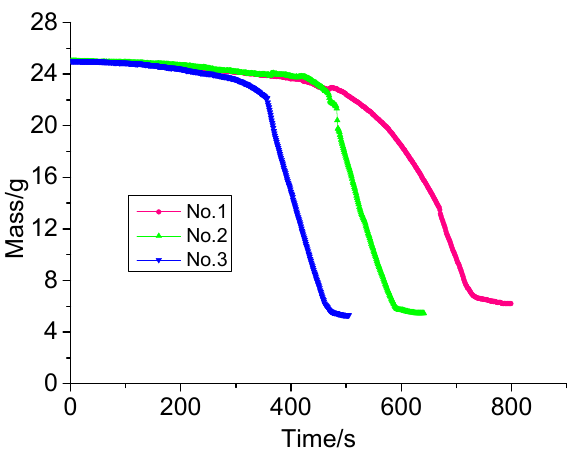
Figure 3. Surface temperature exposed to different heat fluxes.